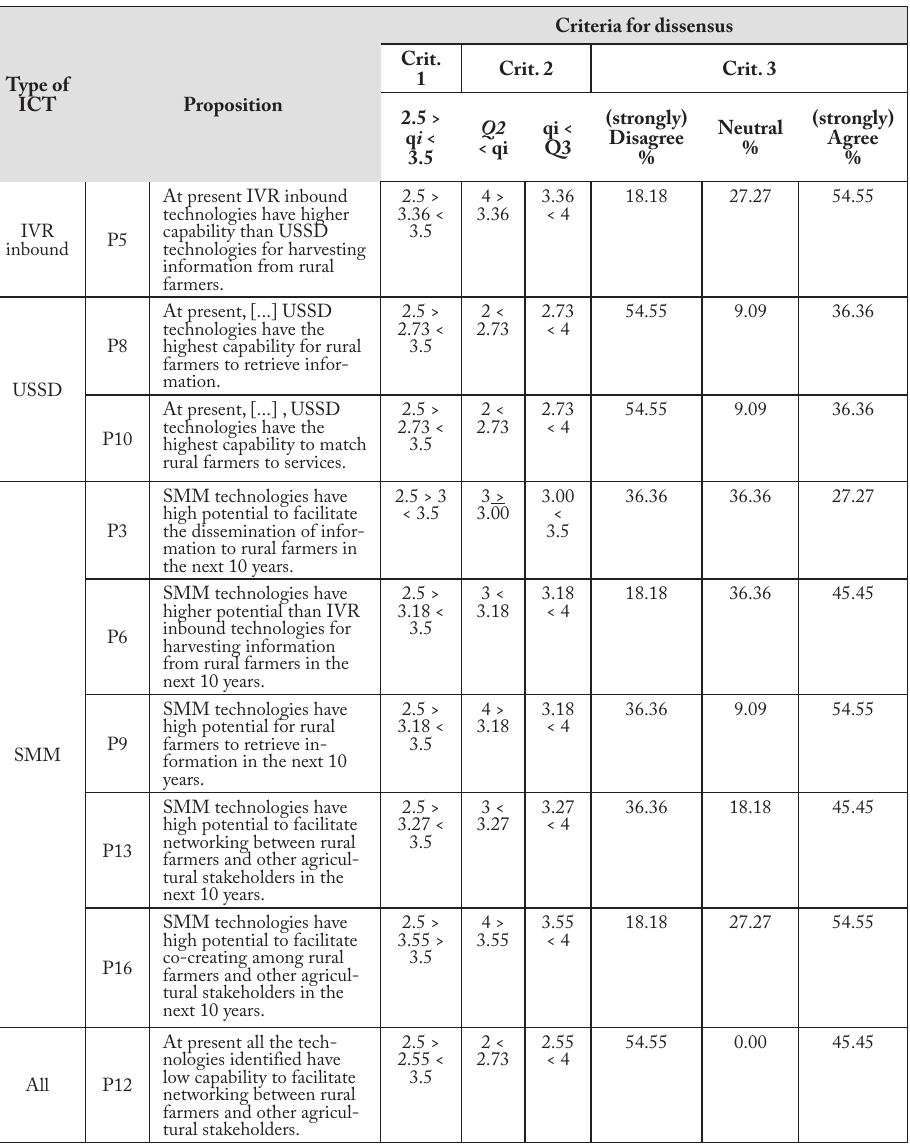
Table 7: Propositions associated with dissensus